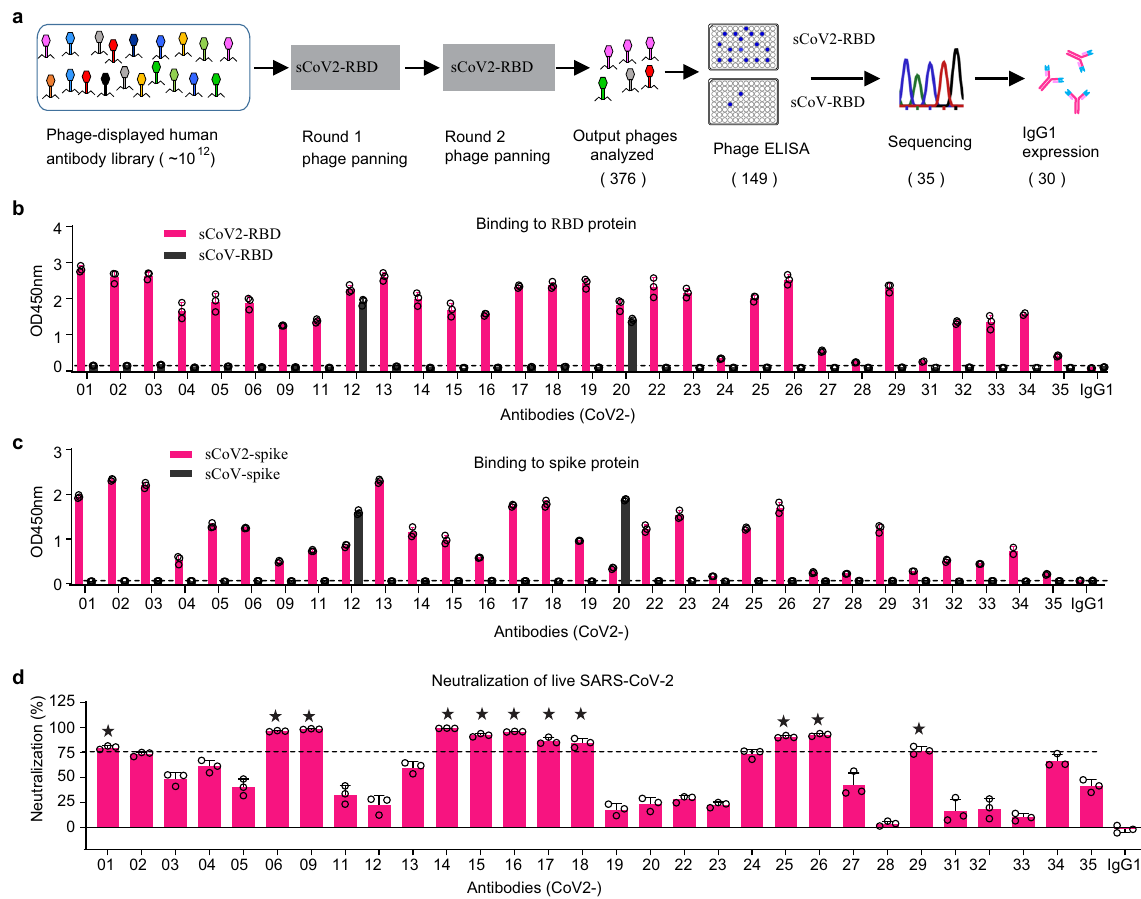
Fig. 1 Isolation of RBD-directed human mAbs with neutralizing activates against SARS-CoV-2. a Flowcharts of the scFv phage library panning and mAb selection process. b , c ELISA binding of puri fi ed mAbs to the RBD proteins ( b ) and the S proteins ( c ) of SARS-CoV-2 and SARS-CoV. The dashed line is 2× the OD450nm of a control IgG1 and as a cut-off for binders. d Neutralization of live SARS-CoV-2 by the antibodies at 10 µ g/ml. The dashed line indicates a 75% neutralization. The stars indicate the 11 mAbs with neutralization above 75%. Error bars indicate SD of (EC 50 ) with an ELISA titration. The K D values were between 1.73 (Fig. 2d, e). The cocktail combination of CoV2-06 and CoV2-14 and 20.8 nM (Fig. 2b and Supplementary Fig. 3b). The EC 50 values were between 0.18 and 7.77 nM (Supplementary Fig. 3c, d).